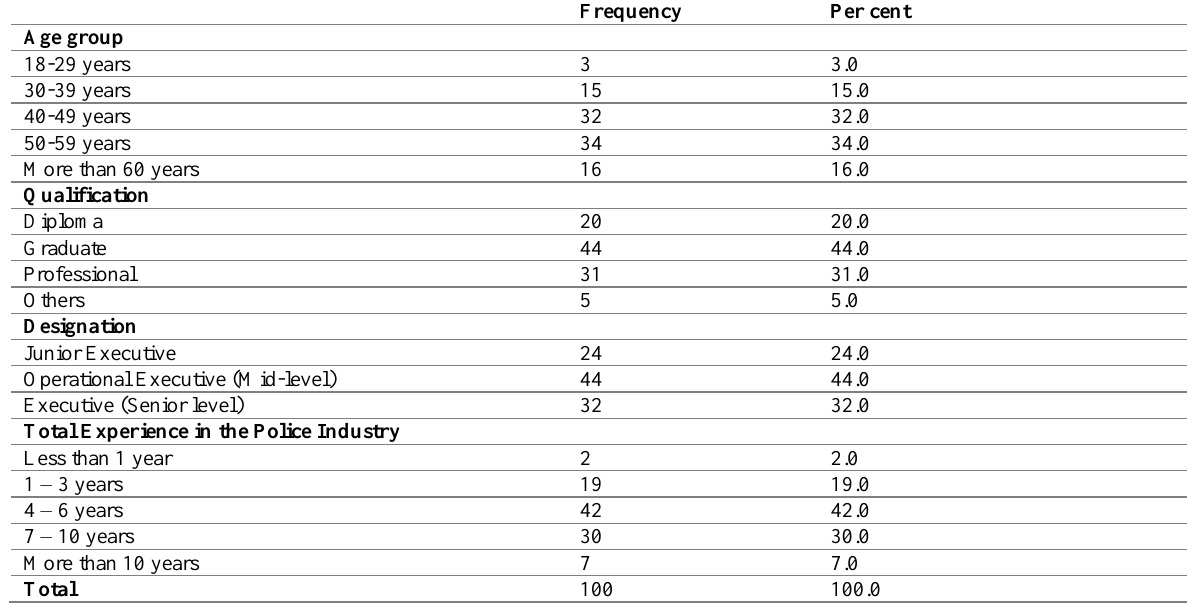
Table 2: Demographic Profile of female police